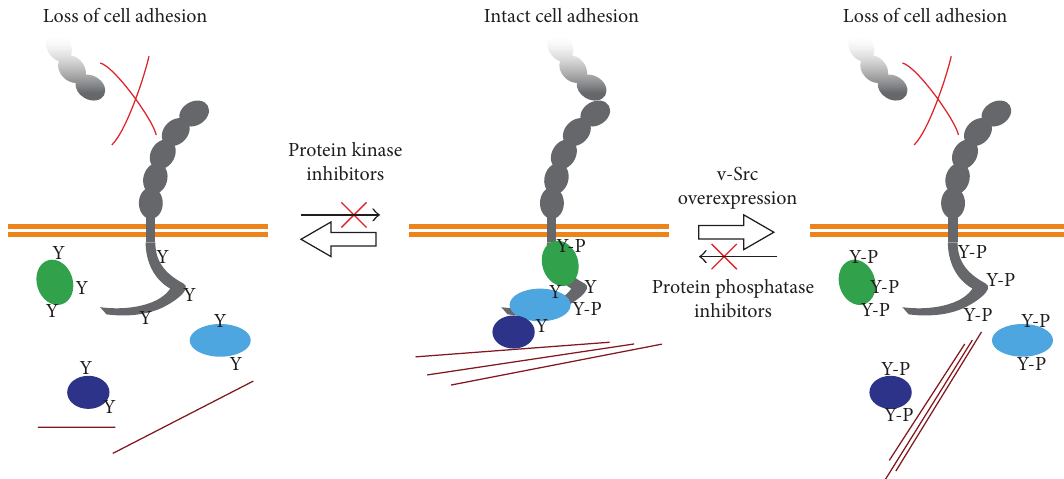
Figure 1: Adherens junction-based cell adhesion requires a tight balance of tyrosine kinases and phosphatases. Oncogenic Src signaling and blockade of phosphatase activity, as well as complete inhibition of kinase activity, can lead to AJ disruption and loss of cell-cell